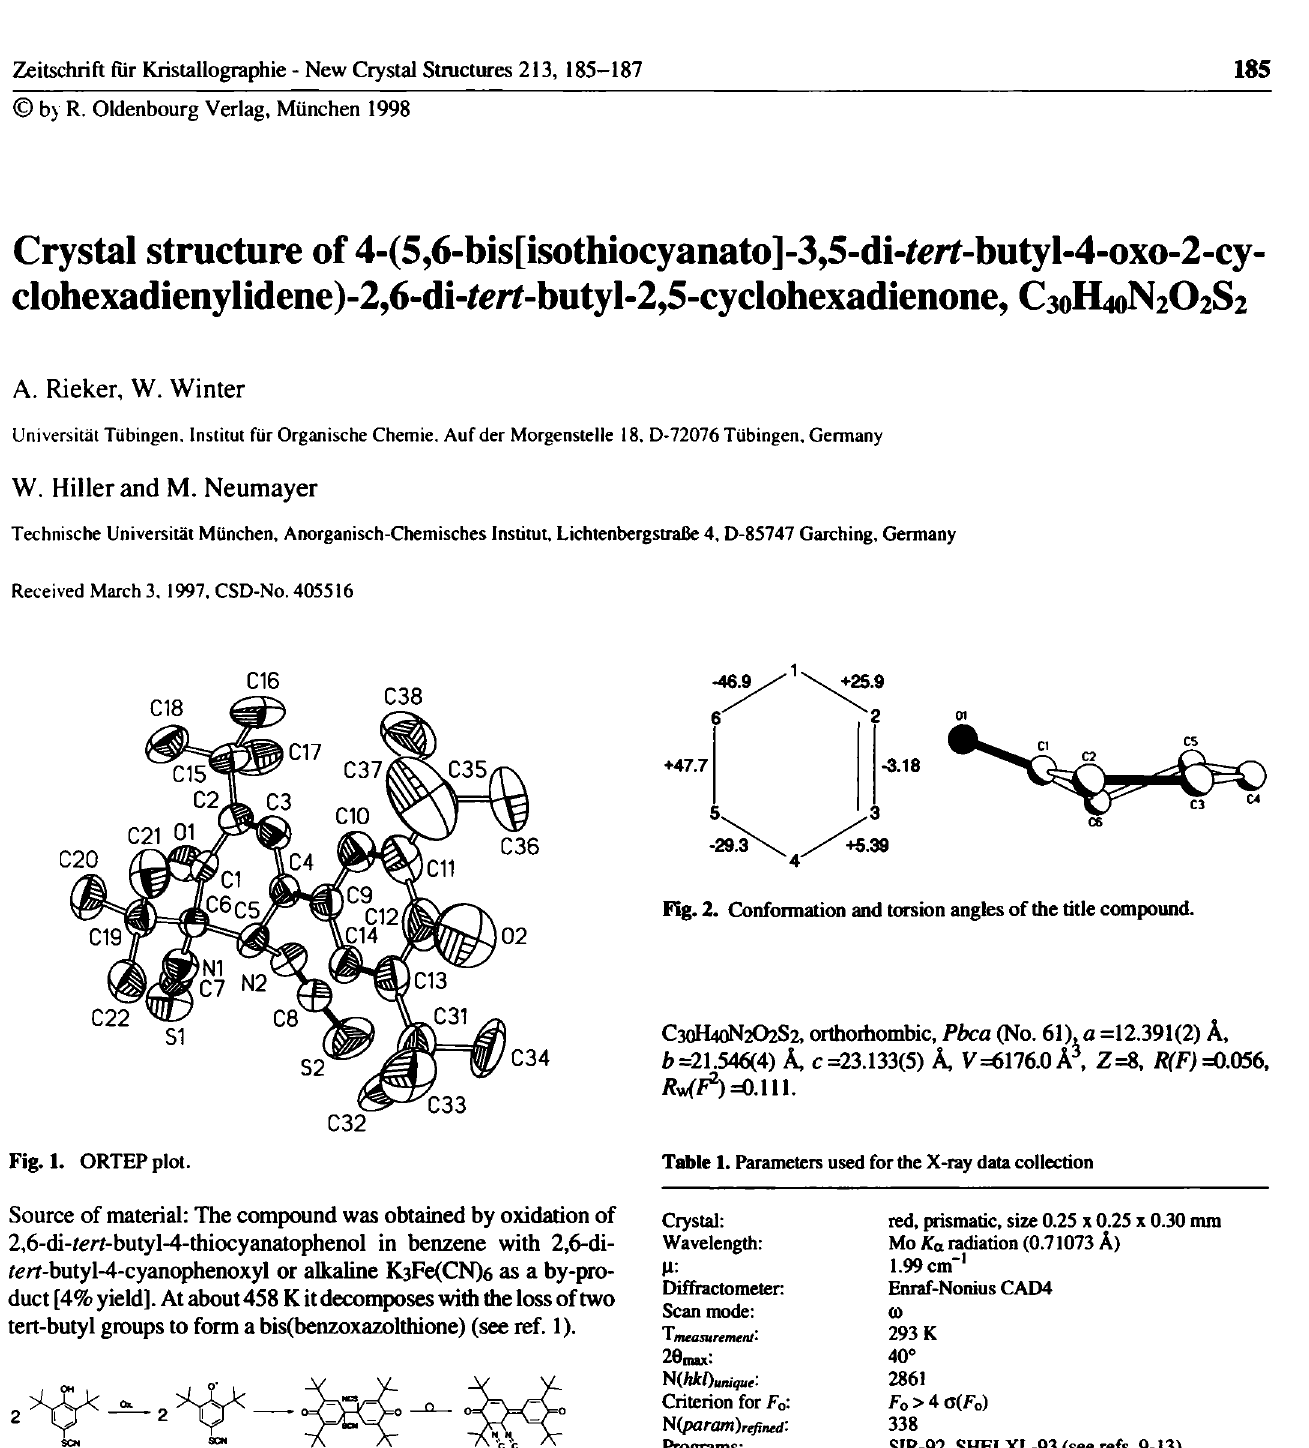
Table 1. Parameters used for the X-ray data collection Crystal: